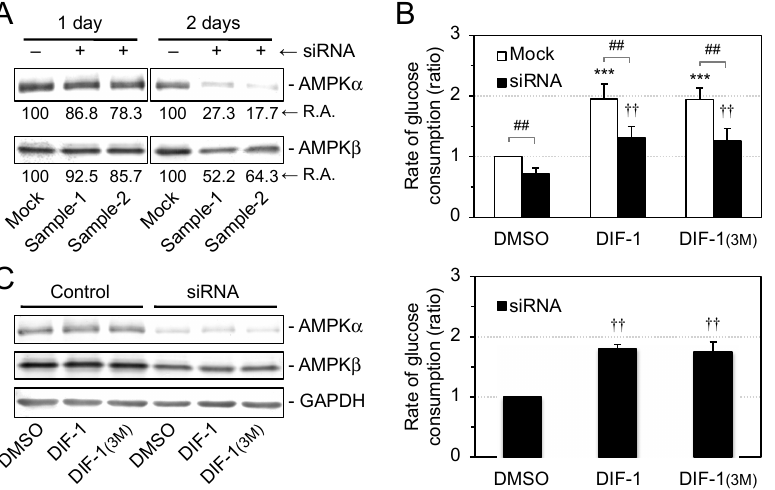
Figure 6. Effects of AMPK knockdown on DIF-induced glucose consumption in confluent 3T3-L1 cells. ( A ) RNAi was performed once (1 day) or twice (2 days) with a mock or siRNA against AMPK α in duplicate (Sample-1 and -2). AMPK α and AMPK β were analyzed by Western blotting, and their relative amounts (R.A.) were assessed. AMPK α was knocked down efficiently after 2-day RNAi. ( B ) Cells with AMPK α knocked down for 2 days were incubated for 10–20 h with DMSO (0.2%), DIF-1 (20 μ M), or DIF-1 (3M) (20 μ M). The glucose concentration of each medium was measured, and the rates of glucose consumption are shown relative to the DMSO control (mock) in the top graph and to the DMSO control (RNAi) in the bottom graph. The mean values and SD of the four independent experiments are presented. *** p < 0.001 versus DMSO control (mock); †† p < 0.01 versus DMSO control (RNAi); ## p < 0.01. ( C ) After the measurements shown in (B), AMPK α , AMPK β , and GAPDH in the same cells were analyzed by Western blotting. AMPK α was knocked down efficiently.